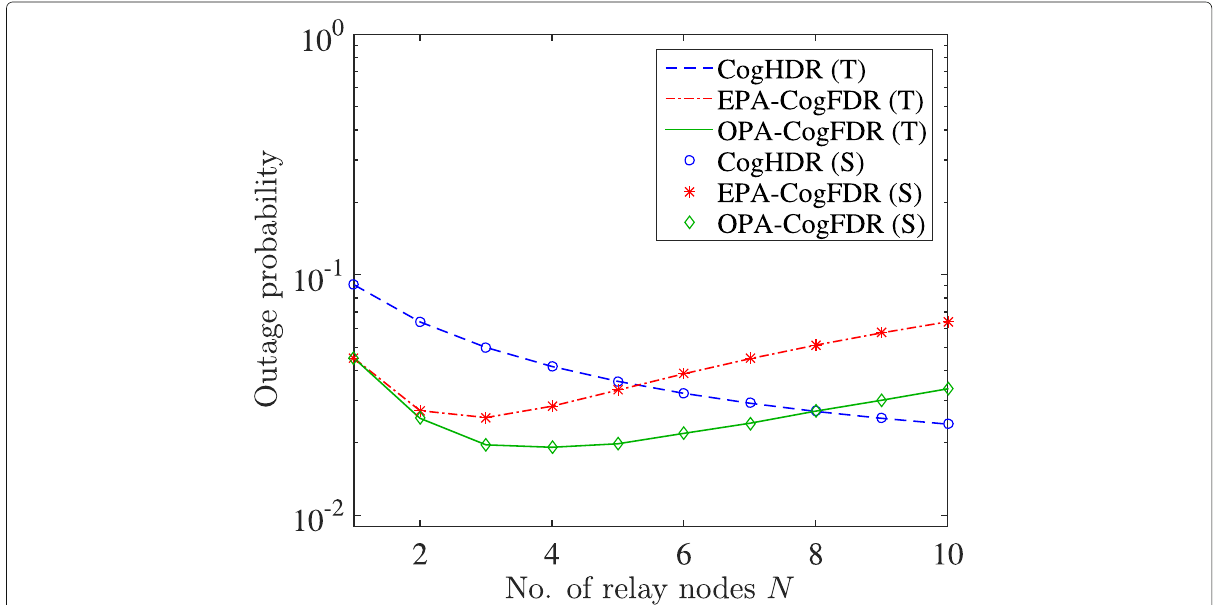
Fig. 8 Outage probability comparison for different number of relay nodes; P / N 0 = 15 dB, I avg / N 0 = 15